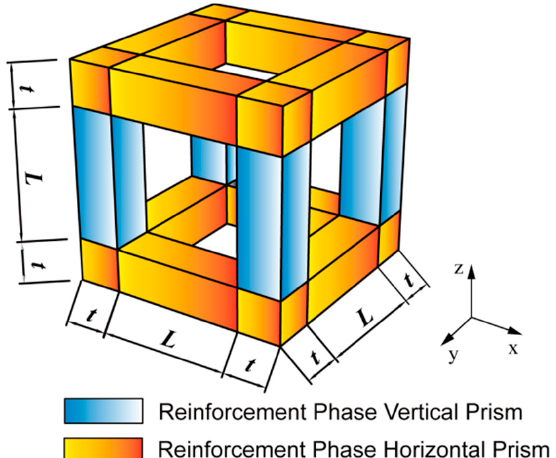
Figure 1. The computational model for representative volume elements and uniaxial tensile of metal/polymer IPC.